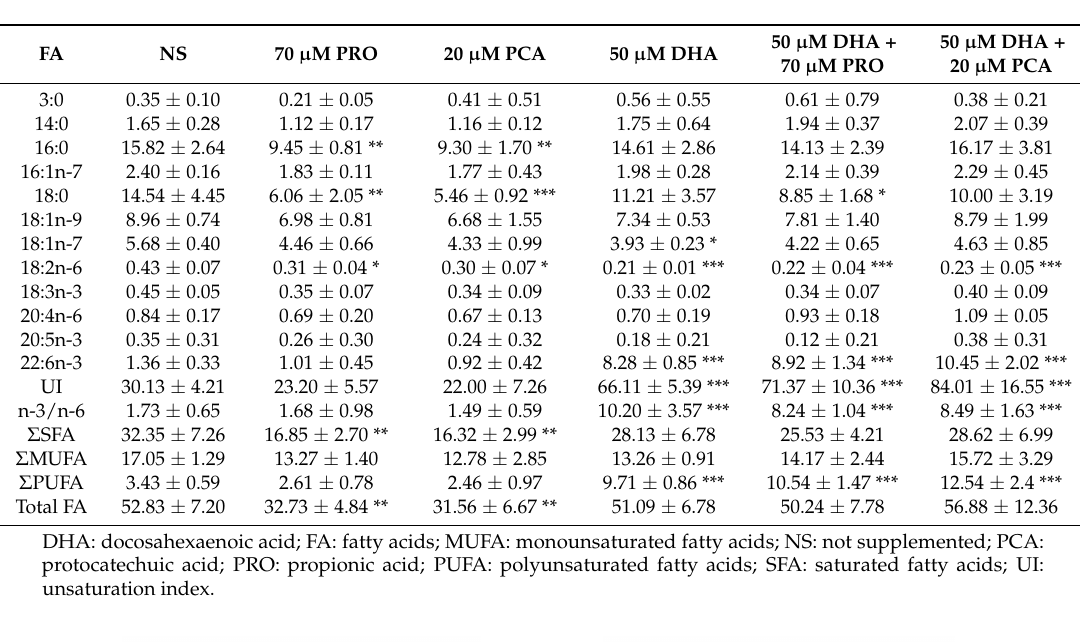
Table 3. Fatty acid content of not supplemented (NS) and supplemented cells after 24 h supplementation. Data were obtained by GC analysis, and are expressed as µg FA/10 6 cells. Data in each group are means ± SD of five samples derived from three independent experiments. Statistical analysis was performed by one-way ANOVA (14:0 p < 0.01; 16:0 p < 0.001; 18:0 p < 0.01; 18:2n-6 p < 0.001; 20:4n-6 p < 0.05; 22:6n-3 p < 0.001; UI p < 0.001; n-3/n-6 p < 0.001; Σ SFA p<0.001; Σ PUFA p < 0.001; fatty acid content p < 0.001) using Dunnett’s post-test to compare NS and supplemented cells (* p < 0.05; ** p < 0.01; *** p < 0.001).